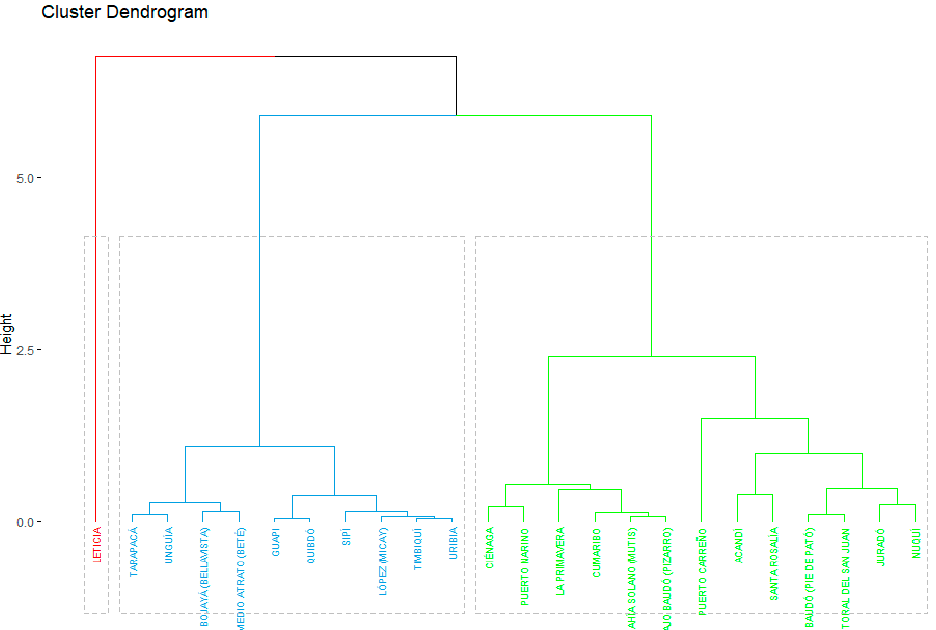
Energies 2022 , 15 , x FOR PEER REVIEW